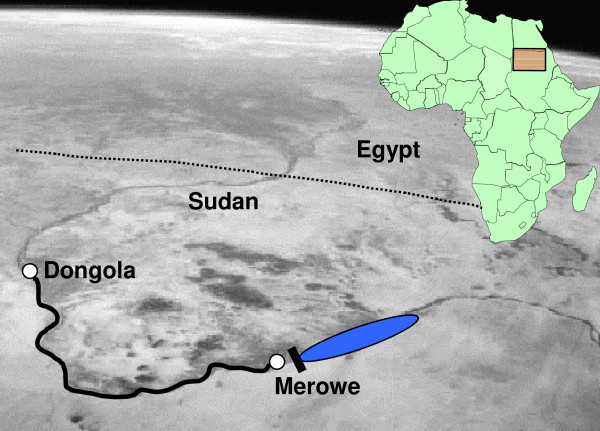
Satellite image of the project area along the Nile, situated between Dongola and Merowe, in Northern State, Sudan. The position of the Merowe dam and the reservoir lake are shown.